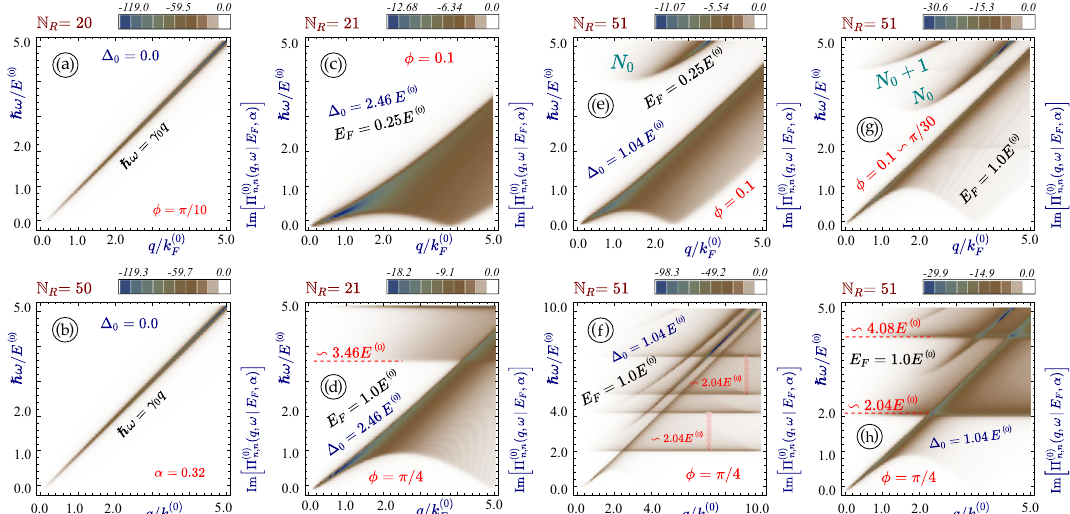
T Figure 4. Single-particle excitation spectrum in α 3 nanoribbons. All panels ( a ) through ( h ) present density − plots as functions of frequency ω and q y for the imaginary part of the non-interacting intra-subband polarization ( 0 ) 20 , 21, 50 and 51. The material bandgap � 0 / E ( 0 ) , ω E F , α) with chosen widths N R function � n , n ( q y = | determined by N R is equal to zero in ( a ), ( b ) but 2.46 in ( c ), ( d ) and 1.04 in ( e )–( h ), respectively. The relative 0.32 (or φ 0.1 for panels ( c ), ( e ) and ( g ), α π/ 10 ) for ( a ) and hopping parameter α was chosen as α ∽ φ = = = π/ 4 (a dice lattice) for the remaining plots ( d ), ( f ) and ( h ( b ) and φ =